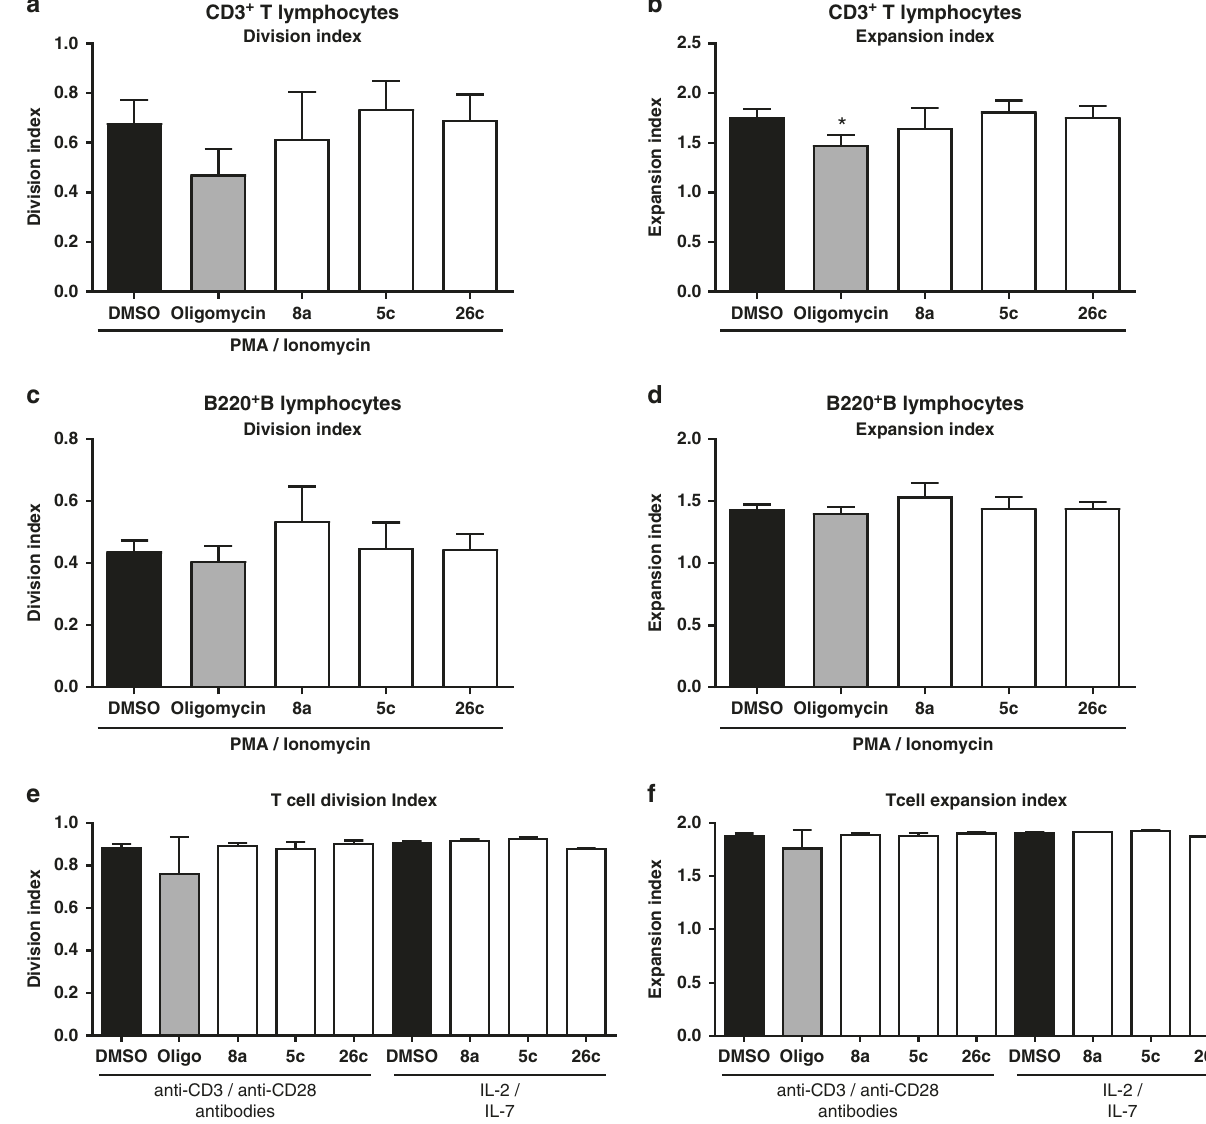
Fig. 10 Screening of a pilot library on cellular functions in Hepa1 – 6. a Effect of compounds 5c and 26c on immune cell proliferation in lymphocytes or isolated T cells. a , b Effect of compounds 5c and 26c on CD3 + T lymphocytes. c , d Effect of compounds 5c and 26c on B220 + B lymphocytes. e , f Effect of compounds 5c and 26c on isolated T cells. Error bars indicate standard deviation based on three replicated calculations. Signi fi cance was tested using an ANOVA test, with Dunnett ’ s multiple comparison test. * p <